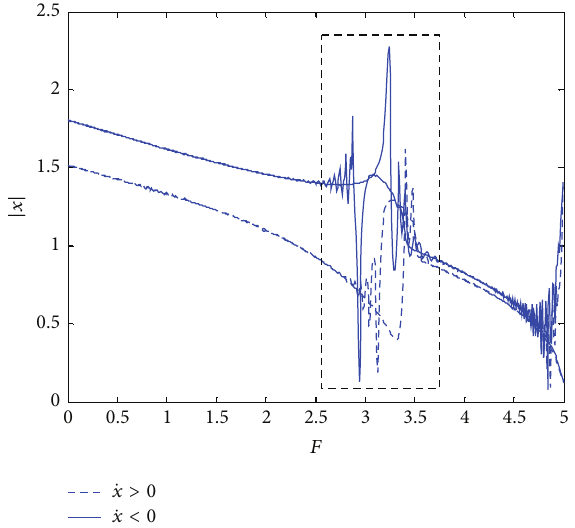
Figure 12: Bistable region of bifurcation.